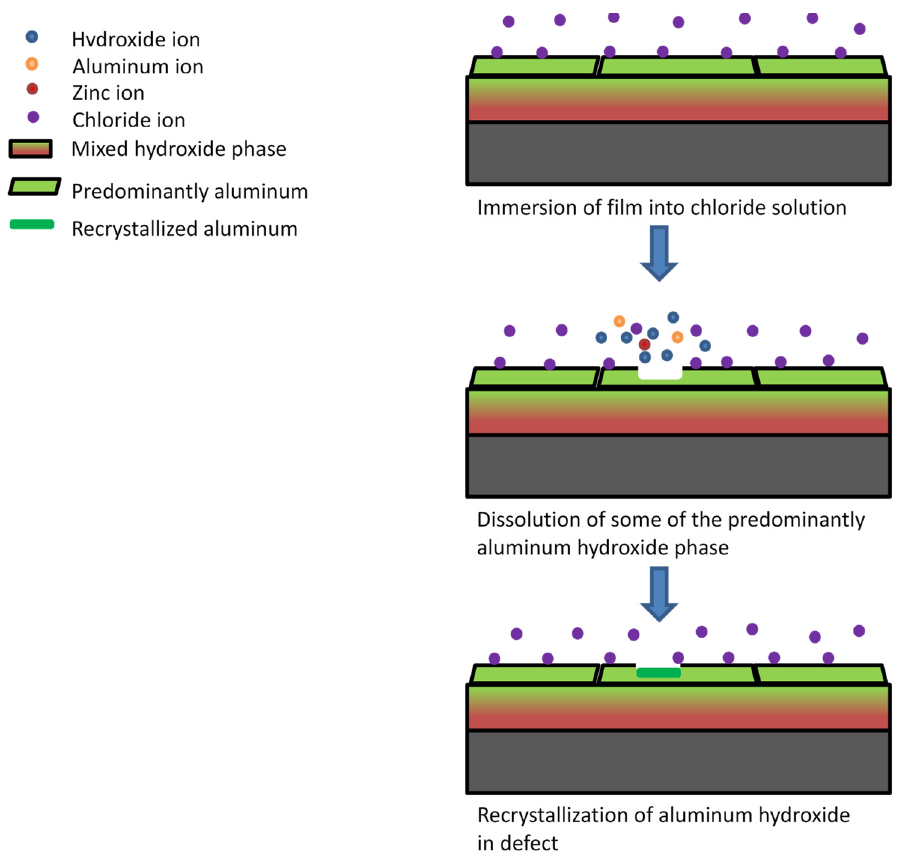
Figure 9. Postulated corrosion mechanism for immersed electrodeposited zaccagnaite film.